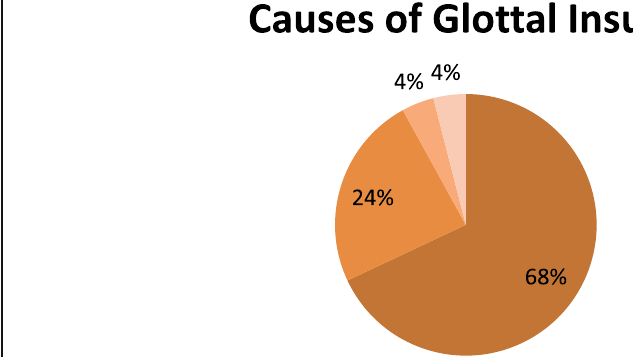
Fig. 1 Causes of glottal insufficiency among studied